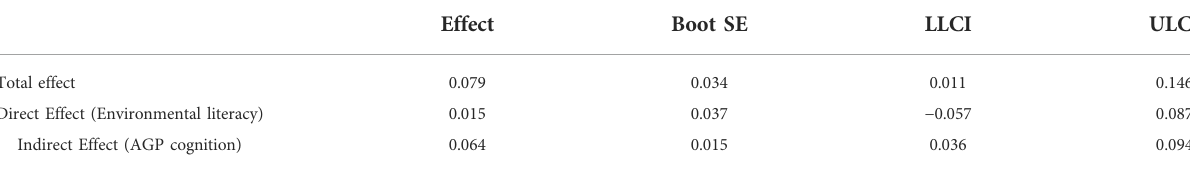
TABLE 8 The mediation effect of AGP cognition (Bootstrap